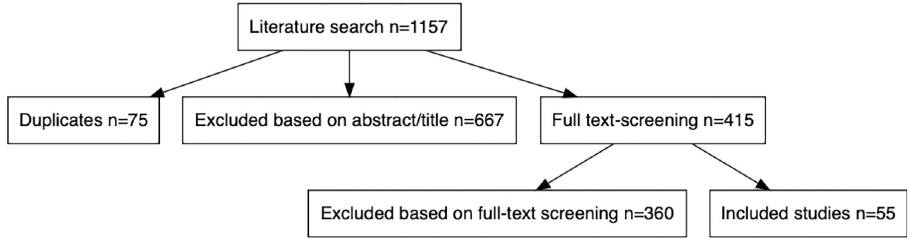
Fig 1. Flow diagram of studies in the review.